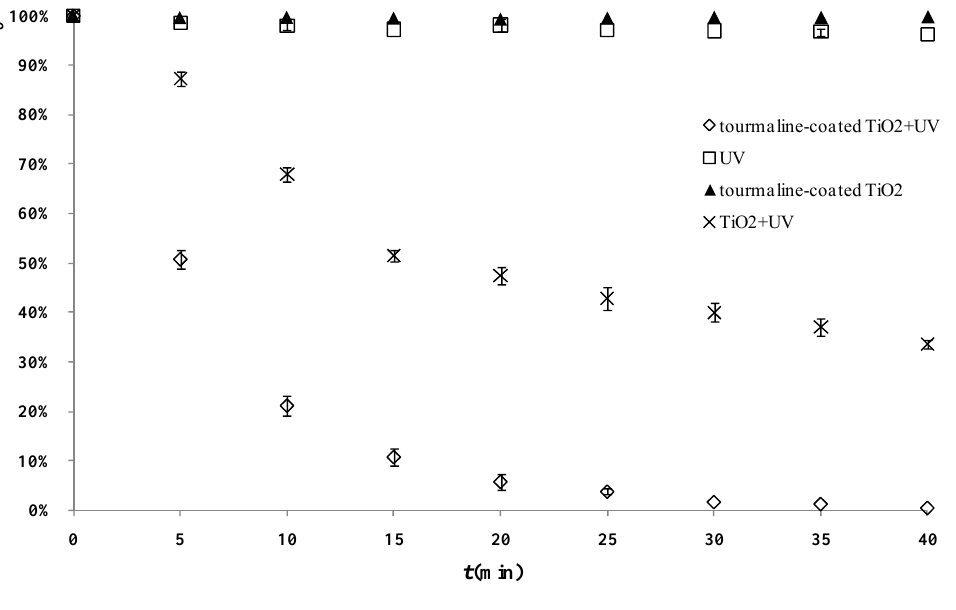
Figure 2. Photocatalytic degradation of 2,4-D, and control experiments without UV or catalyst (reaction conditions: air pumped in at 3 mL/s, C